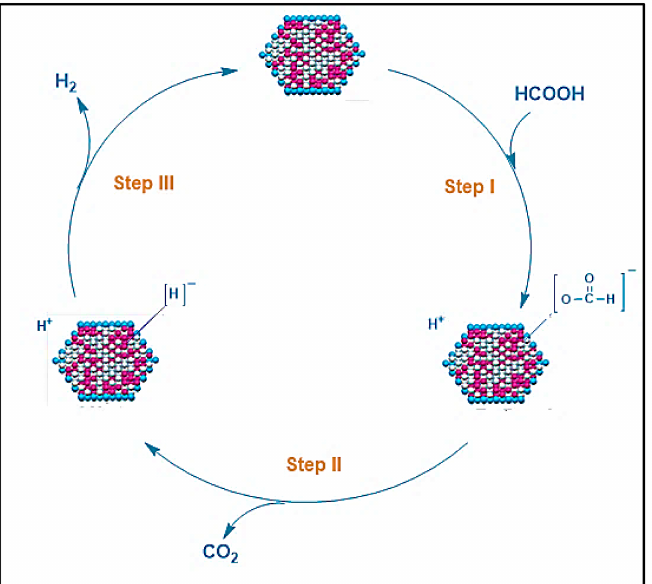
Figure 3. Reaction mechanism described for H 2 generation from FA dehydrogenation catalyzed by metal nanoparticle